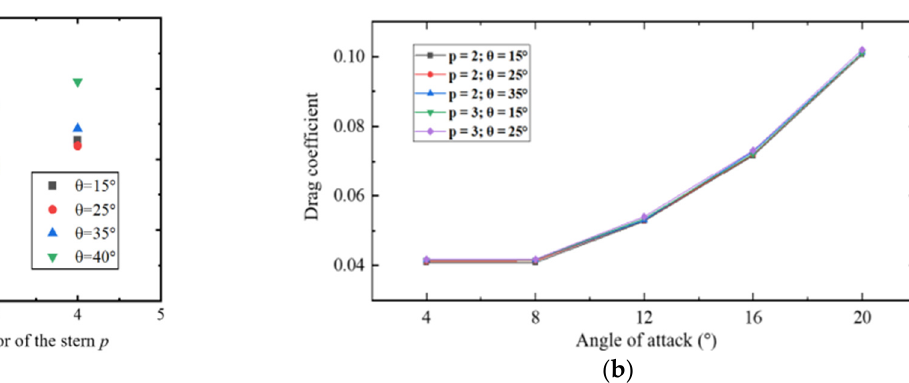
and the model with p = 4; θ = 40°( b ). the model with p = 4; θ = 40 ◦ ( b ).